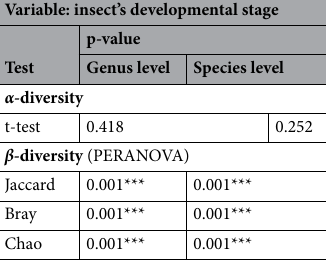
Table 3. Alpha and beta diversity statistics regarding CLB’s developmental stage. Possible significant codes for p-value: ***0.001, 0.01, 0.05, 0.1, 1